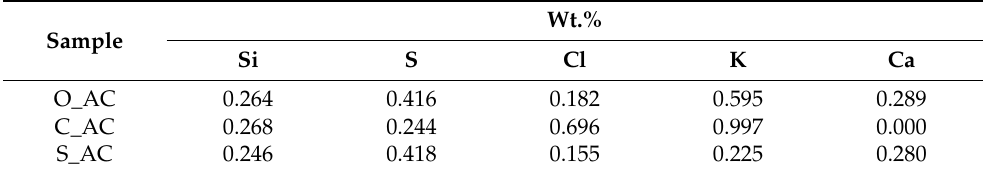
Table 5. Results obtained by XRF method for activated carbons obtained from orange peels, coffee grounds, and sunflower husks.